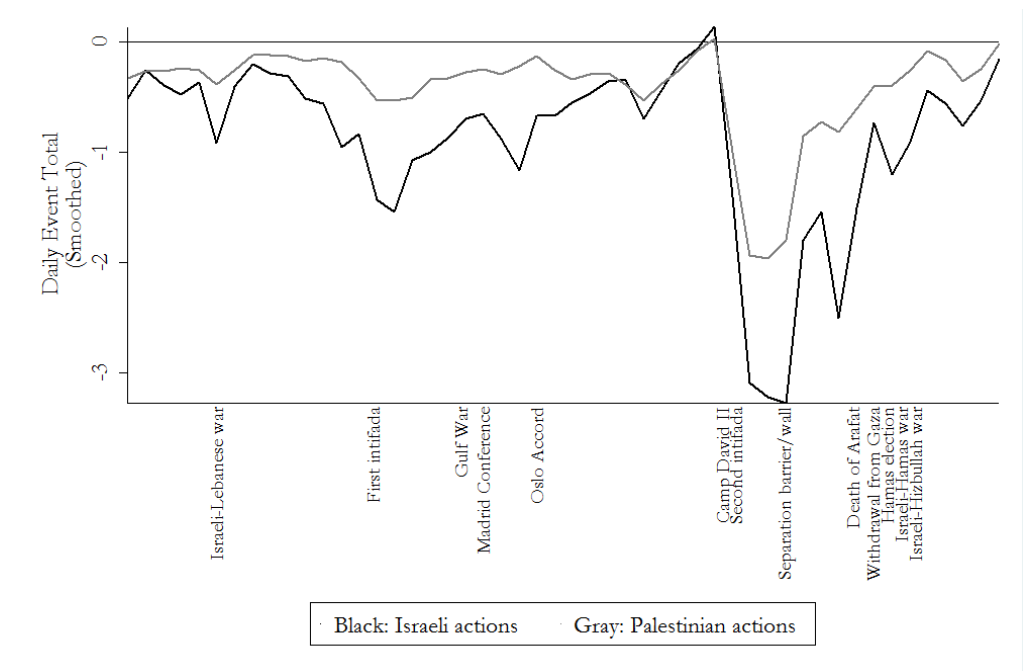
Figure 1: Israeli-Palestinian Interactions: Daily Events, 1979–2009. Legend: Daily event scores, smoothed with polynomial regression, reflect the deepening conflict during the First and Second Intifadas and the lessening of conflict during the period of the Oslo Accords.